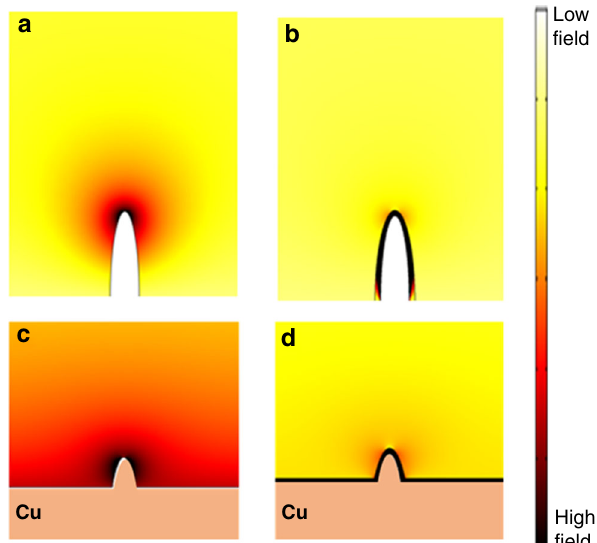
Fig. 5 Theoretical simulation on electric- fi eld distribution for electrochemical Li deposition on protuberance-type electrodes. a Color- coded electric- fi eld distribution near a bare half-ellipsoidal electrode that mimics the folded electrode in operando optical microscopy analysis, showing concentrated fi eld near the tip of the electrode; b the same type of electrode as ( a ) except for having a cation-selective membrane coating, showing strong electric fi eld within the membrane uniformly distributed along the electrode surface; c electric- fi eld distribution on a planar electrode with a surface protuberance, showing considerably stronger fi eld near the protuberance tip than on the fl at surface; d the same type of electrode surface as ( c ) except for having a cation-selective membrane surface coating, showing enhanced fi eld uniformity over the entire electrode